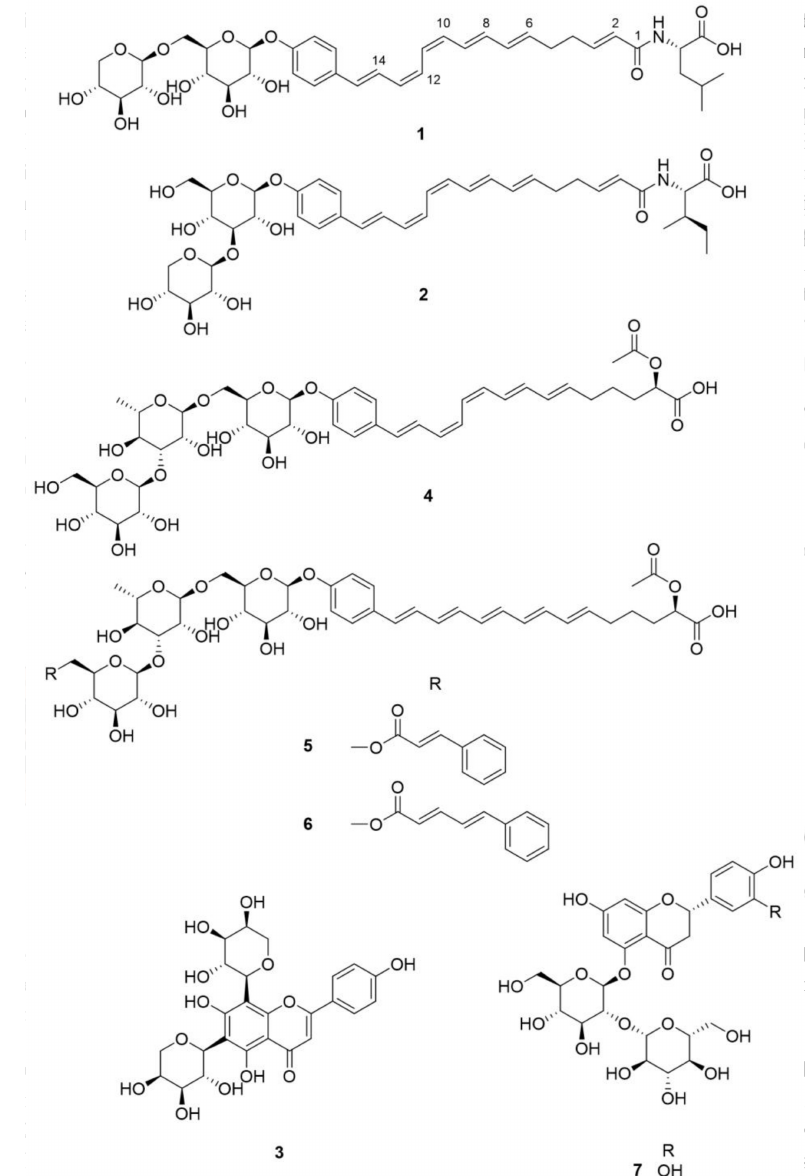
Figure 1. Chemical structures of compounds 1 – 3 isolated from R. franguloides and 4 – 8 previously isolated from B. berchemiifolia